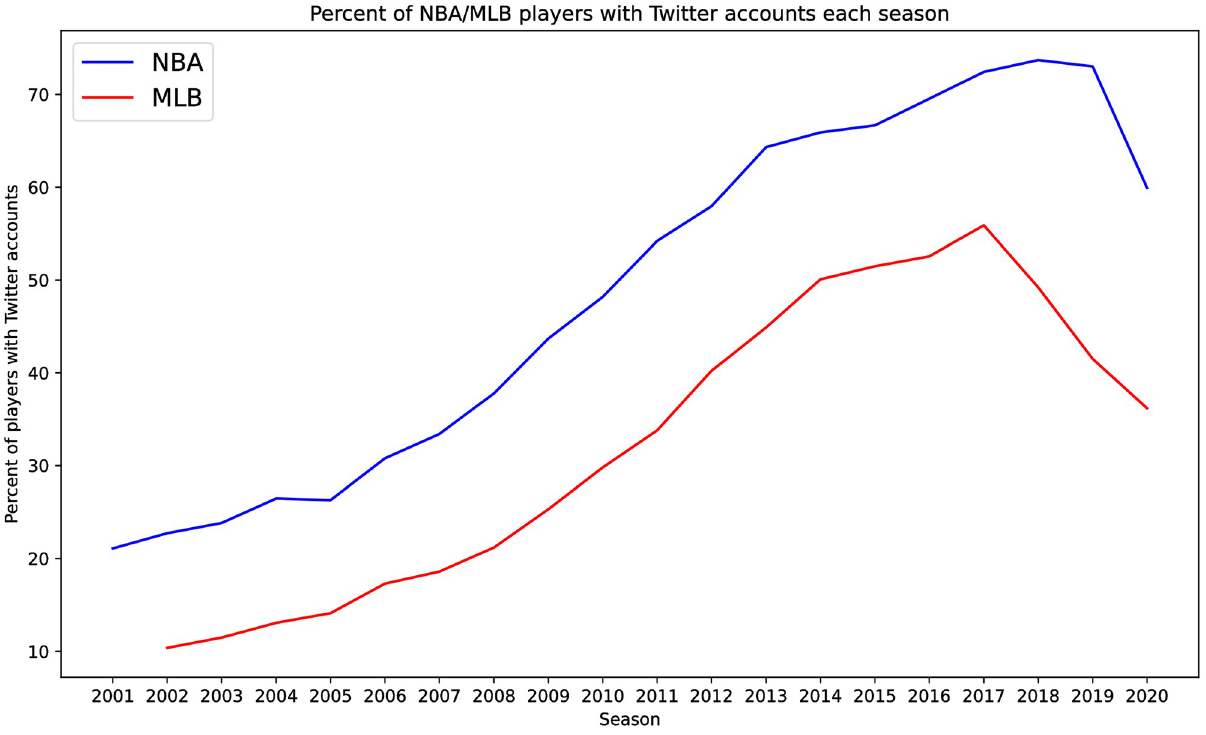
Fig 1. A comparison of the percentage of players who had an active Twitter account before and including July 2020 and who played between 2002 —2018 for the MLB (blue) and between 2001—2019 for the NBA (orange). The datasets we use only give the number of players that have Twitter and who played in a given year, not the specific players that used Twitter during that year. This explains why there is Twitter data as early as 2001, even though Twitter began in 2006.